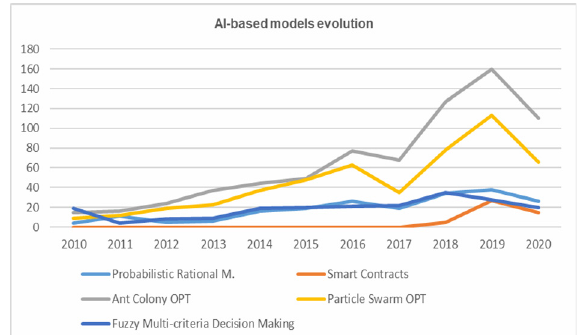
Figure 4. Evolution of AI-based approaches.